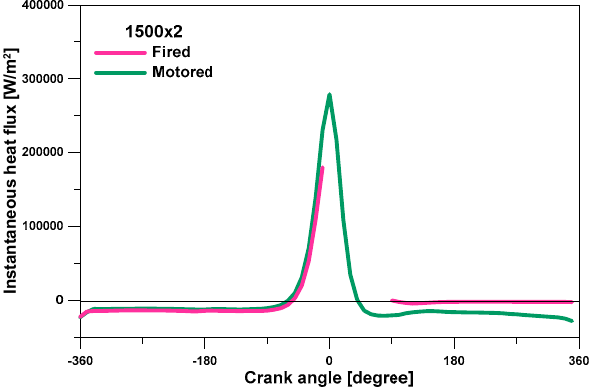
Figure 8. Cycle-resolved measure of the instantaneous heat flux from the in-cylinder gas to the piston head obtained using infrared visualization [33]. Reprinted with permission from Ref. [33] Copyright 2018 SAE International